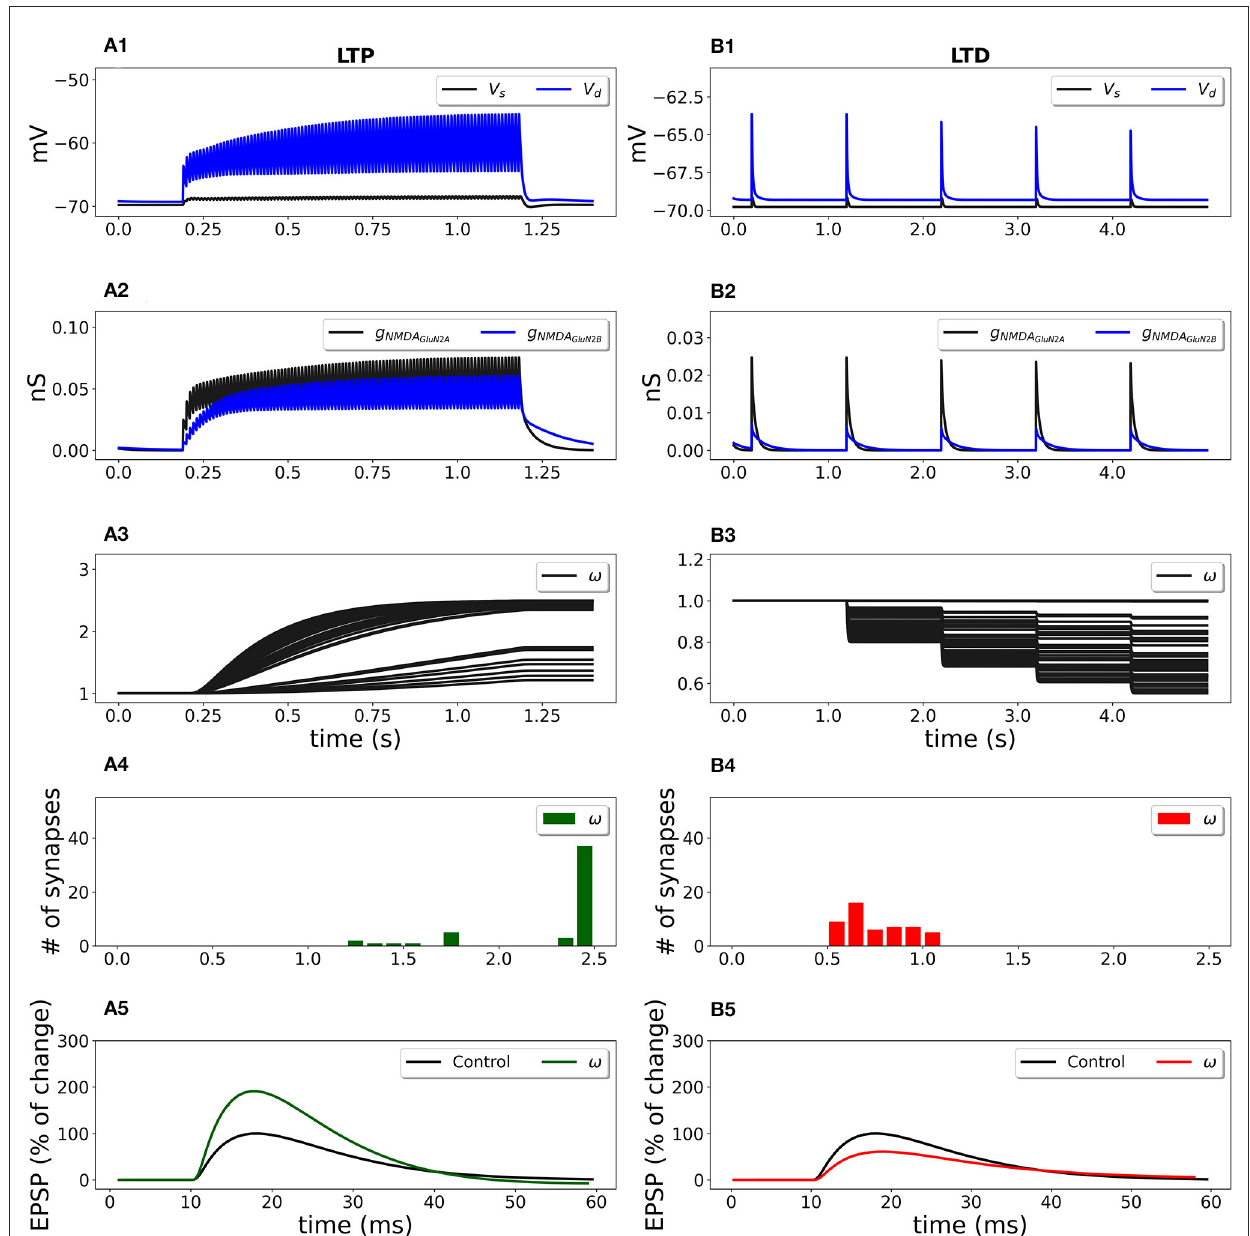
FIGURE6 Synaptic weight change for the frequency-dependent LTP (A1–A5) and LTD (B1–B5) protocols using a multicompartmental model of CA1 pyramidal neuron. Fifty synapses were randomly distributed on the SR apical dendritic branches with the density of 0.8 synapses/ µ m of dendrite 140 µ m from soma and stimulated at 100 Hz for 1 s (LTP protocol) and at 1 Hz for 100 s (LTD protocol). (A1, B1) Membrane potential in soma V s (black line) and membrane potential V d in dendrite (blue line) at a randomly selected synapse location; (A2, B2) GluN2A-NMDAR and GluN2B-NMDAR conductances g NMDA (black line) and g NMDA (blue line); (A3, B3) synaptic weights w of 50 synapses; (A4, B4) distribution of final synaptic weights w ; (A5) GluN 2 A GluN 2 B normalized somatic EPSP before (black line) and after (green line) the synaptic plasticity induction protocol; LTP was induced with the EPSP change of 190 % ; (B5) normalized somatic EPSP before (black line) and after (red line) the synaptic plasticity induction protocol; LTD was triggered with the EPSP change of 61 %